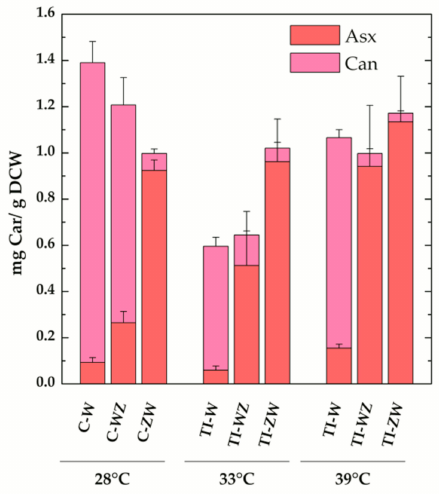
Figure 4. Absolute amounts of total exogenous keto-carotenoids in the engineered constitutive (C-) and temperature-inducible (TI-) Synechocystis strains. Also shown is the individual contribution of the carotenoids (Car) canthaxanthin (Can, light magenta) and astaxanthin (Asx, pink) to the total. Values are expressed as mg Car / g dry cell weight (DCW). Error bars indicate